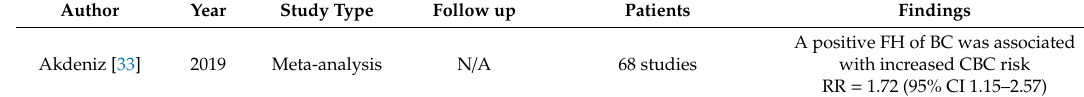
Table 4. Studies looking at the impact of CPM on CBC and survival in BC patients with elevated familial